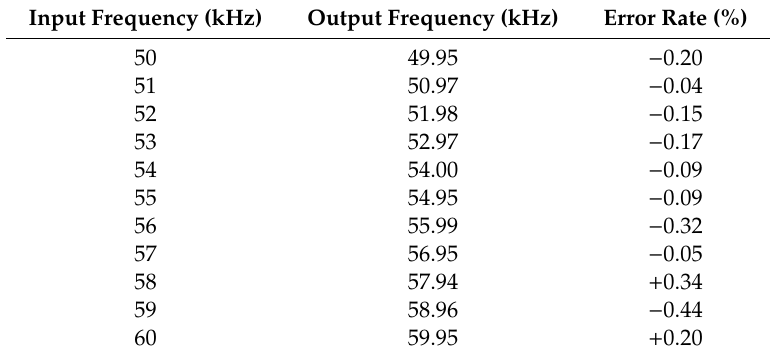
Figure 12. ( a ) Fabricated generator PCB board with minimum/maximum switch input control; ( b ) fabricated display PCB and switching mode power supply (SMPS) circuits. Table 1. Measured input and output frequencies of the main control circuit with error